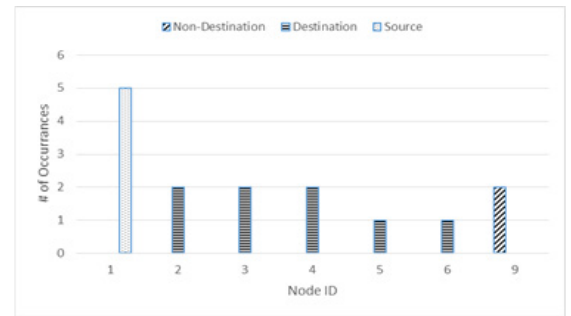
Fig. 14. Number of Paths Each Node Participates in for a Multicast Tree with 10 Nodes and 5 Destinations